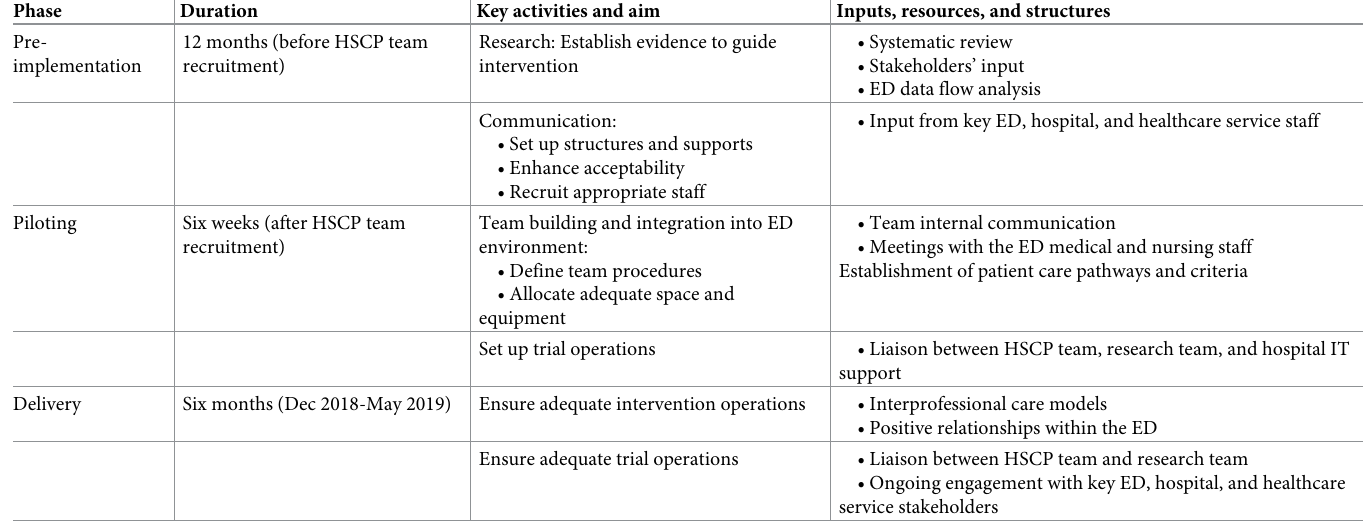
Table 2. Implementation